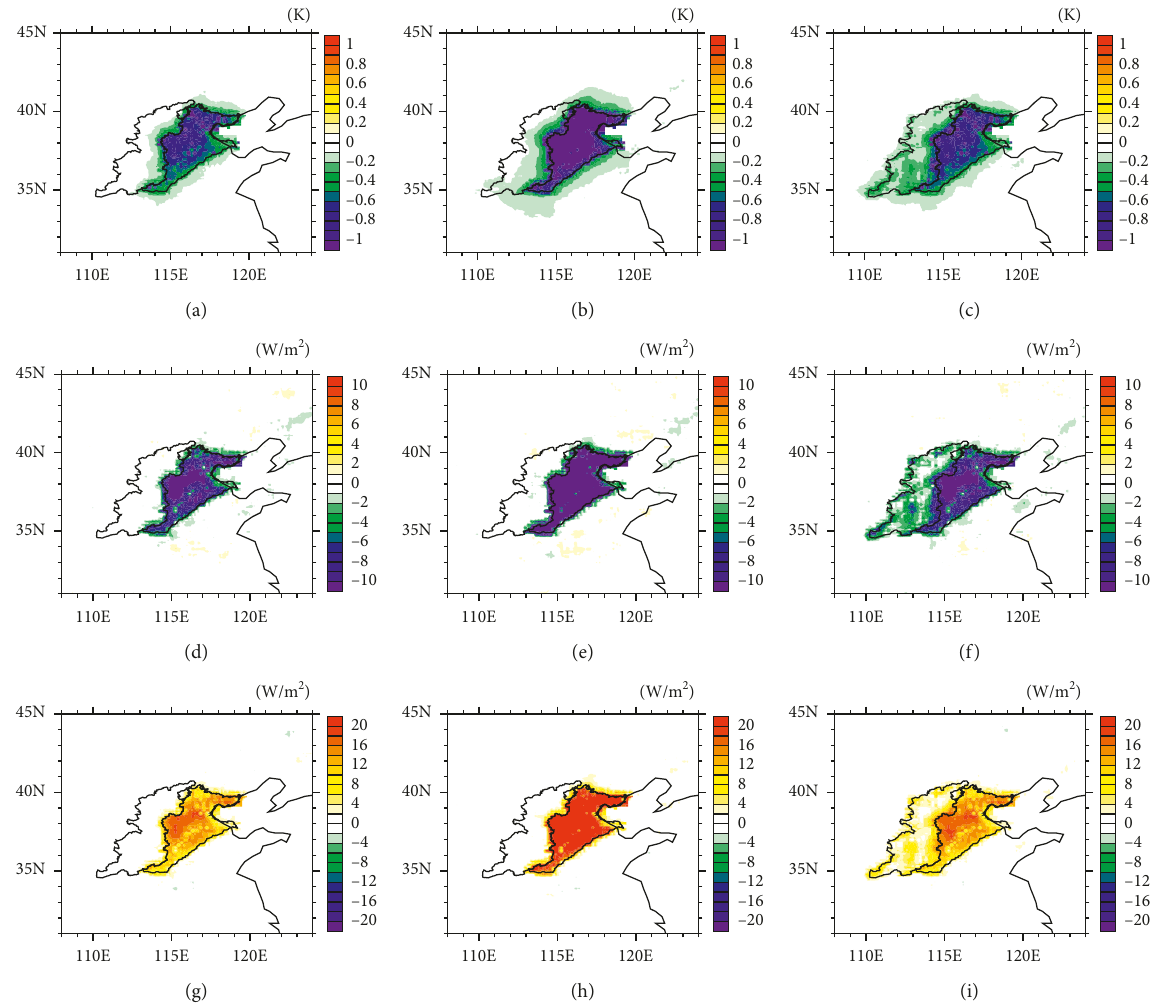
Figure 6: Spatial distributions of mean 2m air temperature difference between tests (a) T1 − CTL, (b) T2 − CTL, and (c) T3 − CTL. Sensible heat flux difference for (d) T1 − CTL, (e) T2 − CTL, and (f) T3 − CTL. Latent heat flux difference for (g) T1 − CTL, (h) T2 − CTL, and (i) T3 −